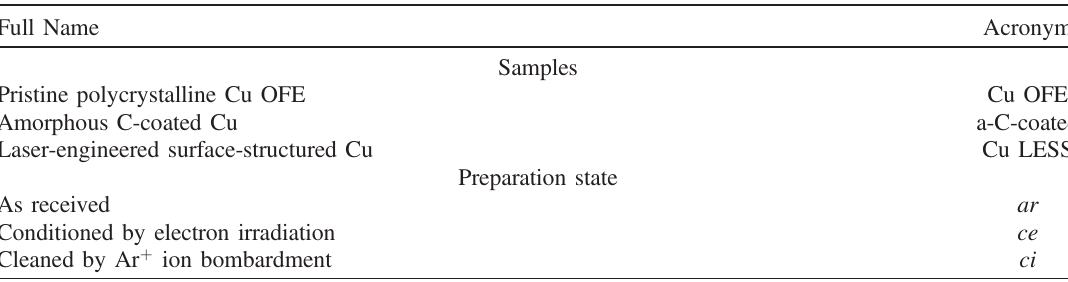
TABLE II. Summary of sample